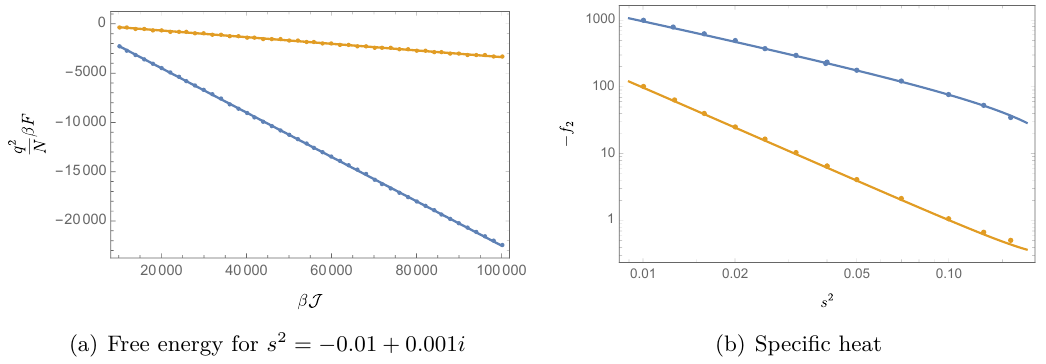
Figure 7 . In both cases, we plot in blue the real part and in yellow, the imaginary one. (a) The free energy as a function of the inverse temperature for s 2 = − 0 . 01 + 0 . 001 i . The dots correspond to numerically integrating (D.6) for different temperatures, while the solid line corresponds to the fit by a function of the form (D.17). The result is within 1% of the analytic expression (D.17), except for the imaginary part of f . (b) The coefficient − f as a function of s 2 in a logarithmic 0 2 scale. The dots correspond to numerically integrating the free energy at each s 2 and fitting by a √ function of the form of (D.8). The solid line is the analytic expectation f = π 2 4 s 2 + 1 /s 2 , which 2 gives a negative, linear in temperature specific